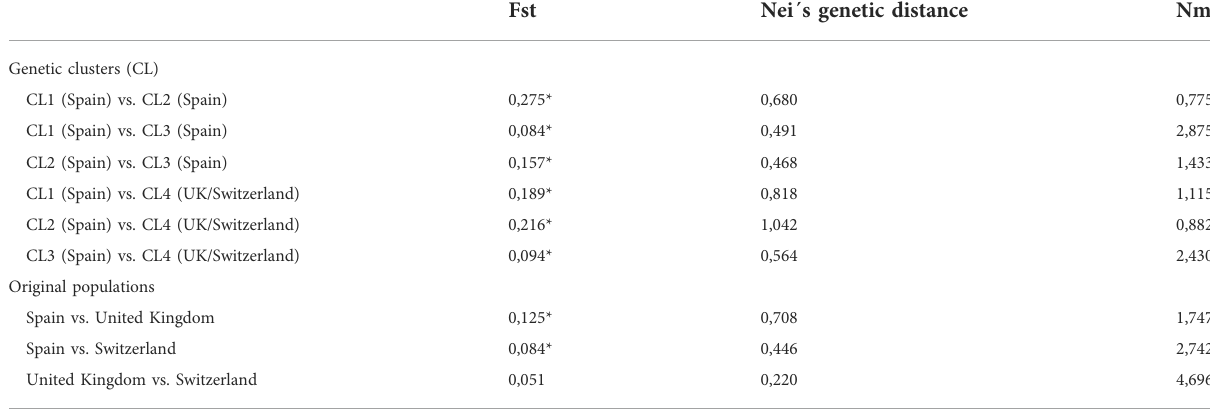
TABLE 4 Pairwise genetic differentiation between the genetic clusters detected by DAPC analysis in addition to the original populations from Spain, United Kingdom, and Switzerland measured by the fi xation index based on Wright ’ s F statistics (F st ), Nei´s genetic distance and the number of effective migrants (Nm). Clone-corrected data con fi rmed the